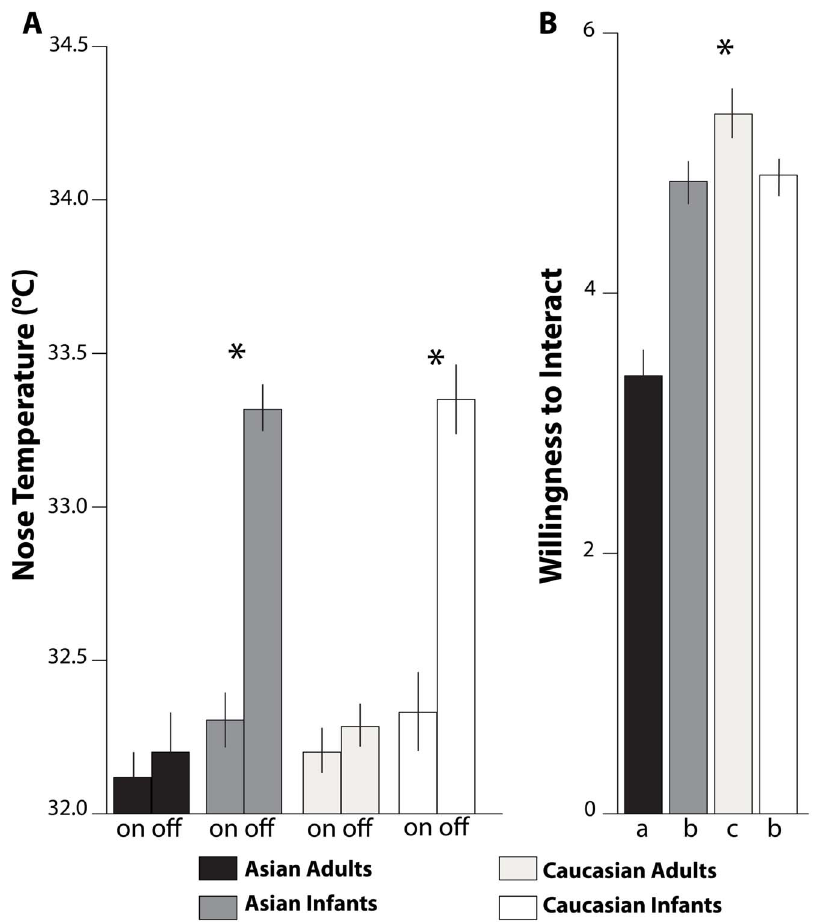
Figure 3. Italian participants. Responses to the presentation of the faces of Asian adults (black), Asian infants (dark grey), Caucasian adults (light grey), and Caucasian infants (white). (A) Mean levels ( 6 SEM) of the tip of the nose temperature at onset (on) and offset (off) of the picture presentation. (B) Mean levels ( 6 SEM) of scores for Willingness to Interact with the person. Bars with different subscripts (a, b, and c) are significantly different in Tukey HSD post-hoc